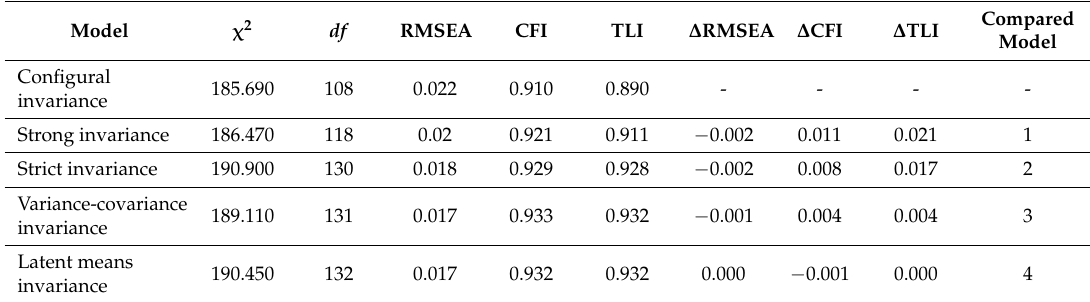
Table 3. Goodness of fit indices of the models tested.